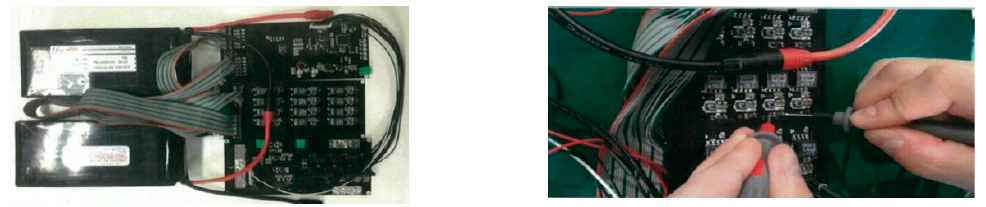
Figure 16. Embedded battery management board and an example of how the cell voltage was measured. Table 7. SOC and cell voltage deviation measurement data.